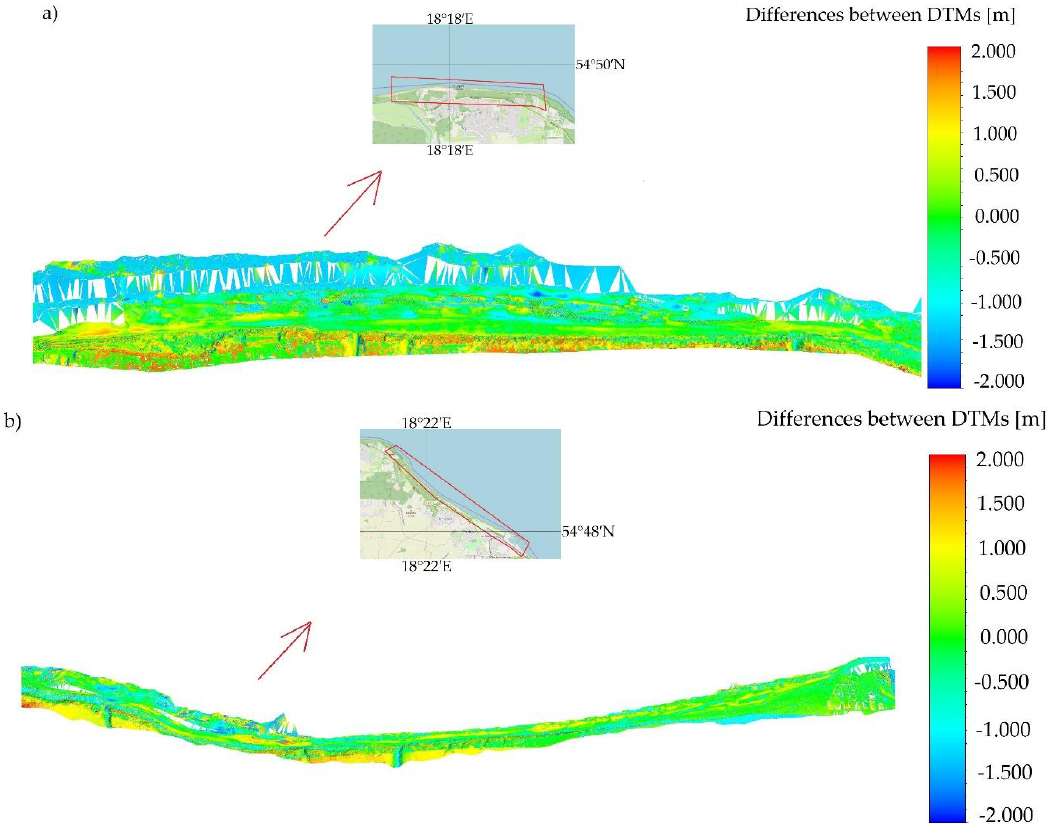
Figure 10. Result of the bathymetric scanner measurements of geometric di ff erences before and after the autumn and winter season in ( a ) the northern part of the area; and ( b ) the south-eastern part. Figure 10 shows the geometric di ff erences before and after the autumn and winter